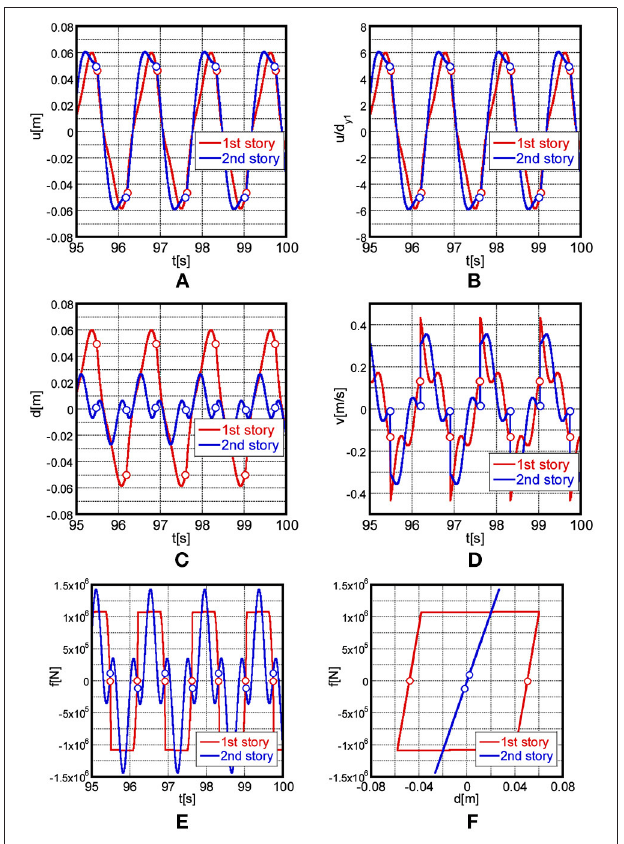
FIGURE 4 | Time-history response of 2DOF elastic-perfectly plastic system under critical multiple impulse with V = 0.3 [m/ s ] by time-history response analysis, (A) Relative horizontal displacement, (B) Relative horizontal displacement (normalized by d y 1 ), (C) Interstory drift, (D) Relative horizontal velocity, (E) Restoring force, (F) Restoring force-interstory drift relation.